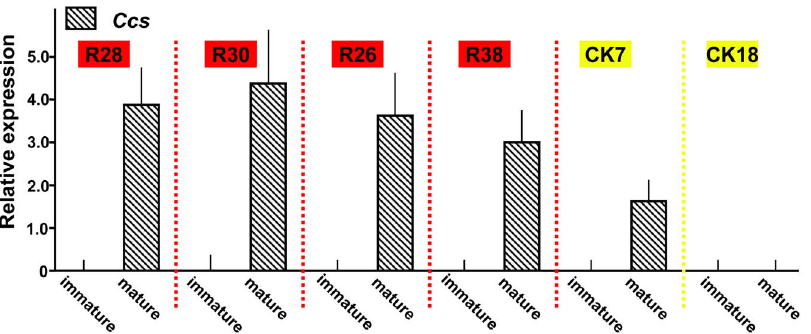
Figure 5. Expression pattern of Ccs . Total RNA obtained from immature and mature pericarps of R28, R30, R26, R38, CK7 and CK18 was used for quantitative RT-PCR analysis. Each result represents the average of three independent biological replicates 6 SE (n=3), with a significance level of P # 0.05.